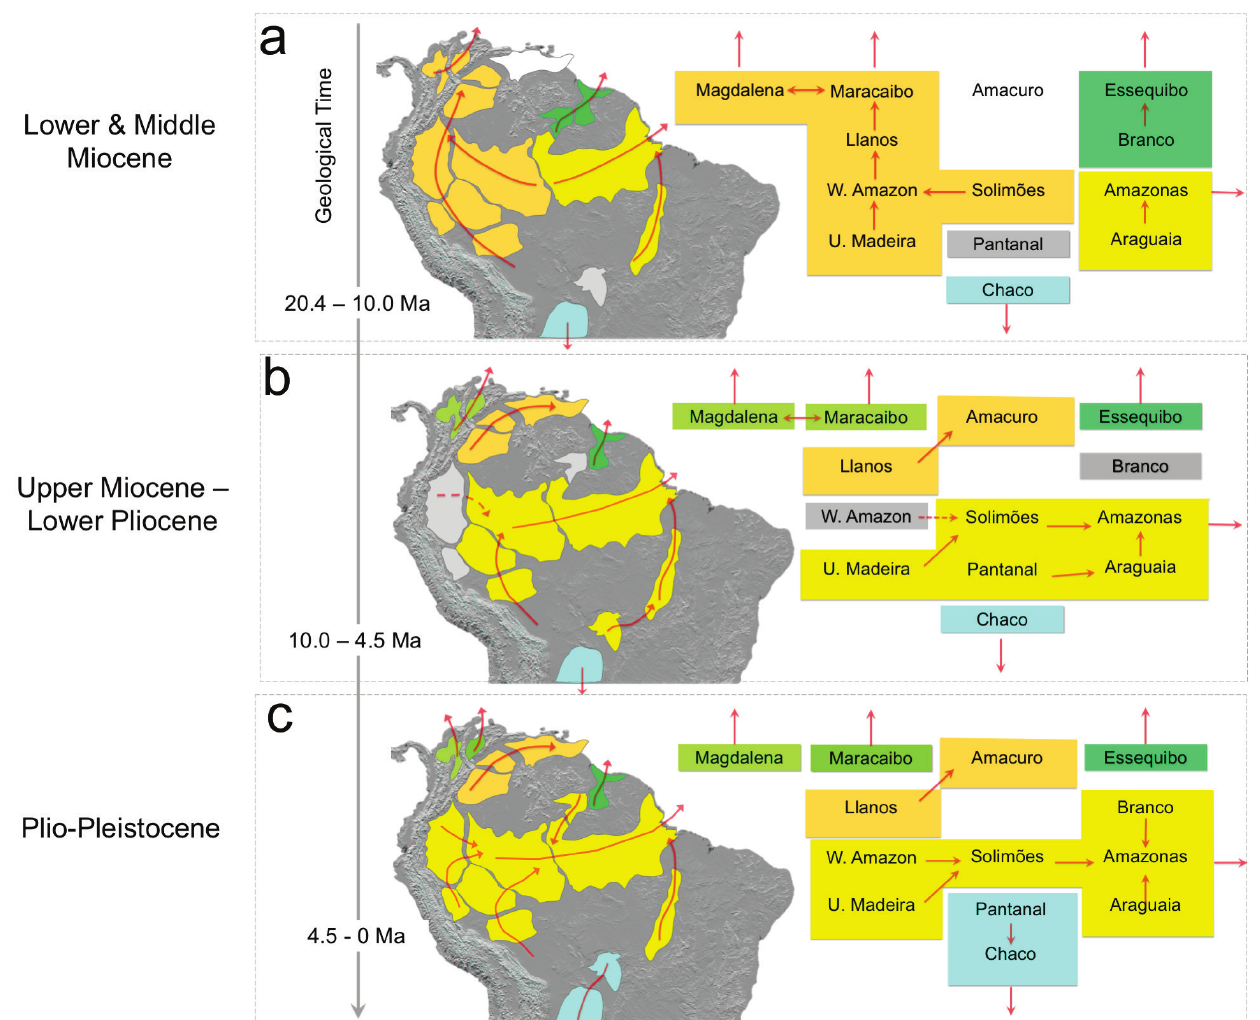
Fig. 5. Summary of hydrological connections among major sedimentary basins of northern South America through the Neogene. Caribbean-draining Andean foreland basins in orange. Atlantic-draining basins contributing to transcontinental Amazon in yellow. Other north Atlantic-draining basins in shades of green. South Atlantic-draining (La Plata) basins in blue. Connectivity as a block-design landscape evolution model at right preserving general spatial relationships. Red arrows depict predominant direction of sediment and water flow. Double-headed arrow indicates bidirectional connections during that time interval. Vicariance events when basins of the same color change to different colors between time intervals; geodispersal events when basins with different colors change to same color. Connections of basins in grey are poorly constrained by avai - lable data. Basin in white is entirely marine. “W. Amazon” refers to the combined Putumayo, Napo, Marañón and Ucayali sedimentary basins, “Llanos” to the combined Llanos, and Barinas/Apure basins, “Amazonas” to the combined Amazonas and Marajo basins, and “Essequibo” to the Proto-Berbice basin. Sedimentary basins with four letter abbreviations at left in top panel. Base-maps with modern coastlines and topography to facilitate